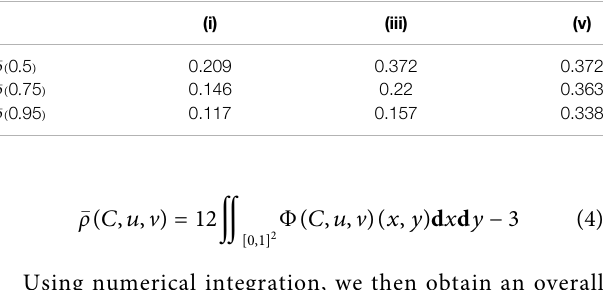
TABLE 3 | Conditional correlation as Spearman ’ s rho ( ρ ) for the upper tail of C 2